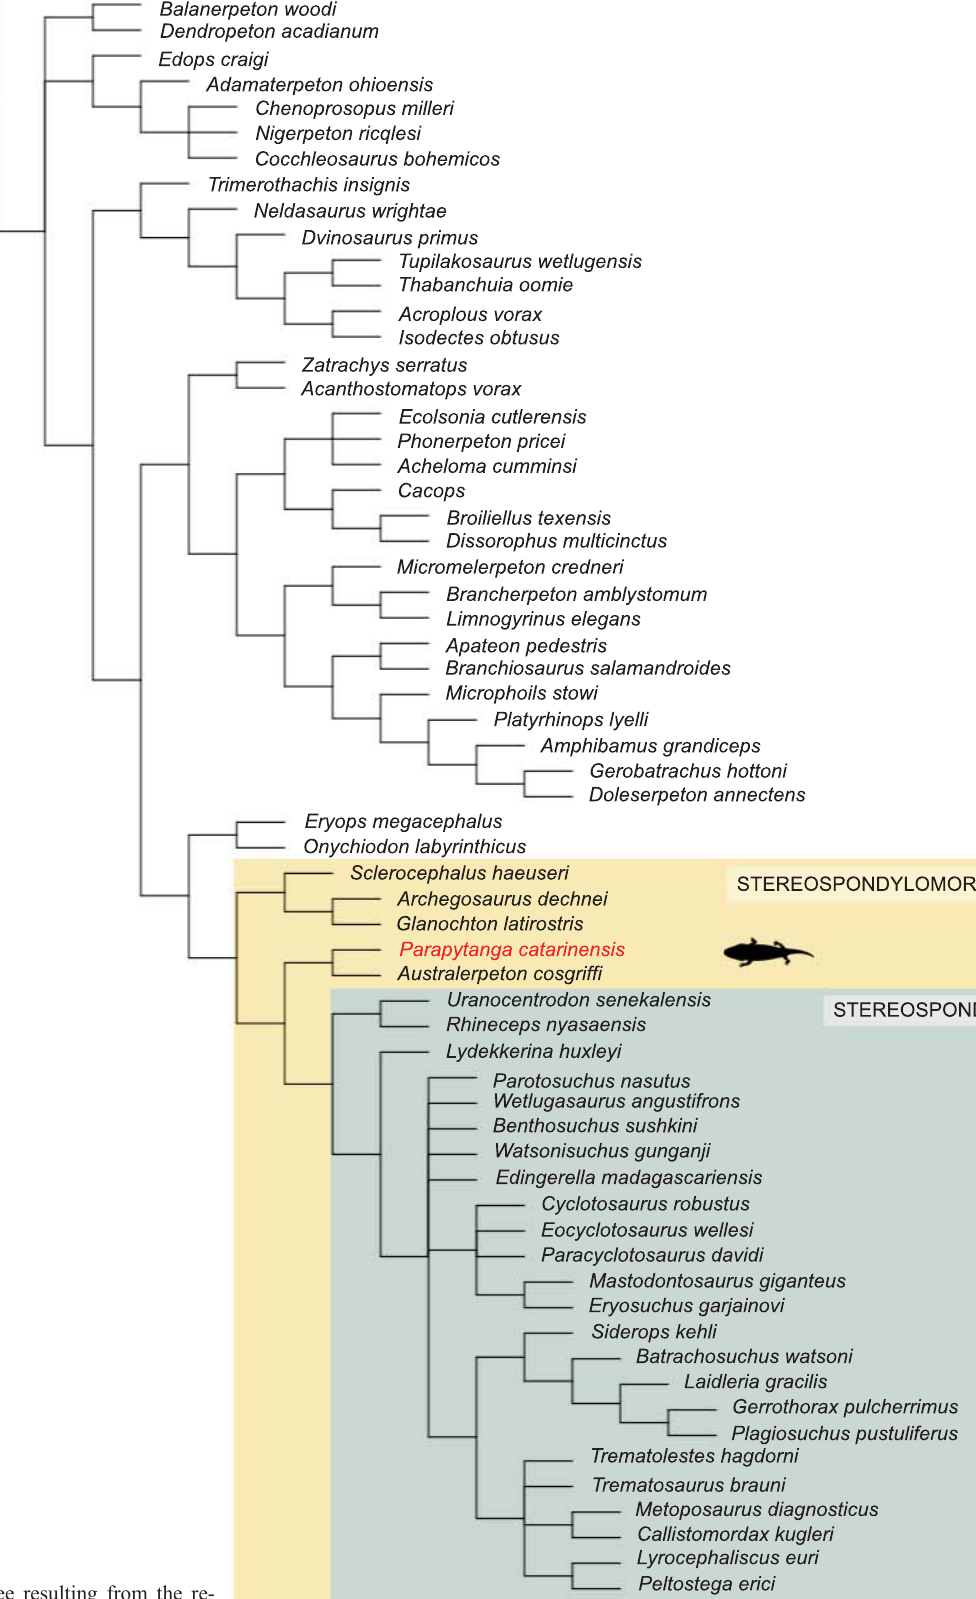
Fig. 7. Strict consensus tree resulting from the re- duced analysis of Schoch’s (2013)